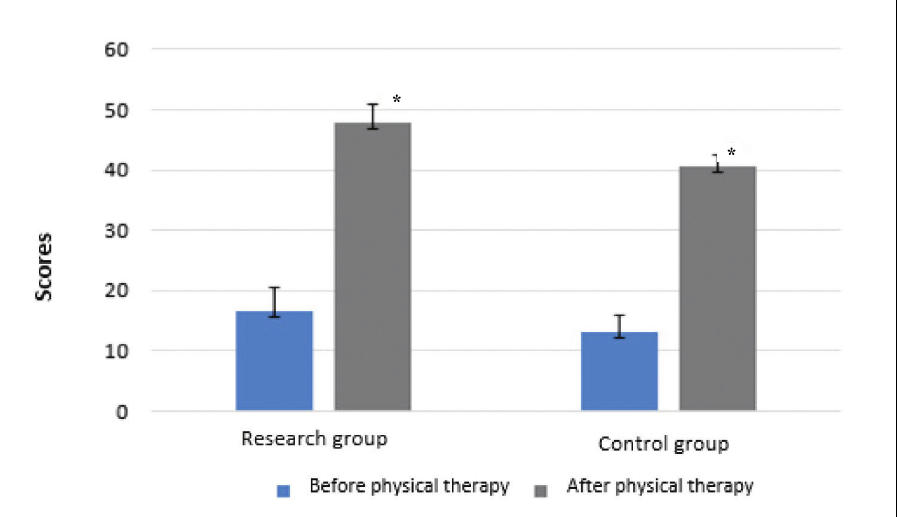
Figure 1. Berg Balance Scale value in Group 1 and Group 2 before and after physical